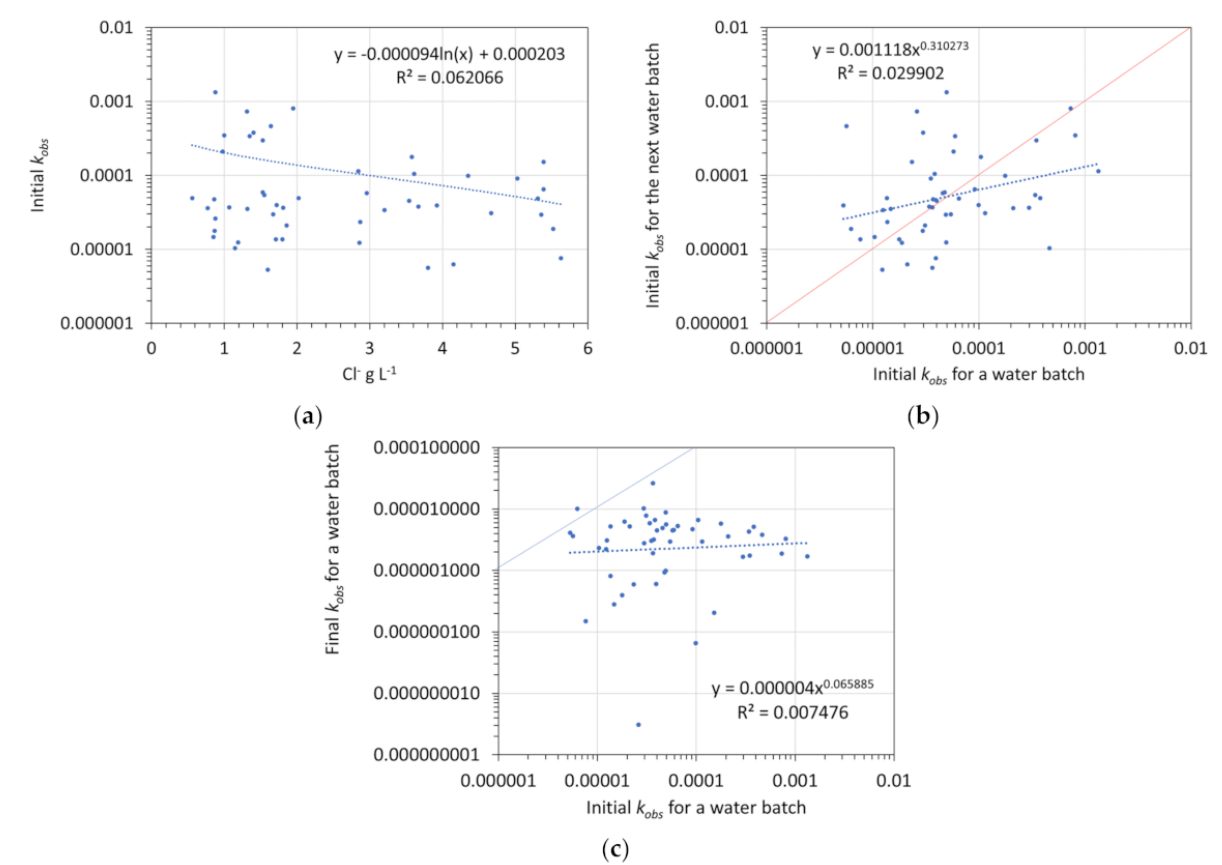
Figure 17. Variation in Cl − rate constant. ( a ) Initial rate constant versus feed water Cl − content; ( b ) initial rate constant for a batch versus initial rate constant for the next batch; ( c ) initial rate constant for a batch versus the final rate constant for a batch. Dotted blue line is a regression line. Solid blue line is a line of equal